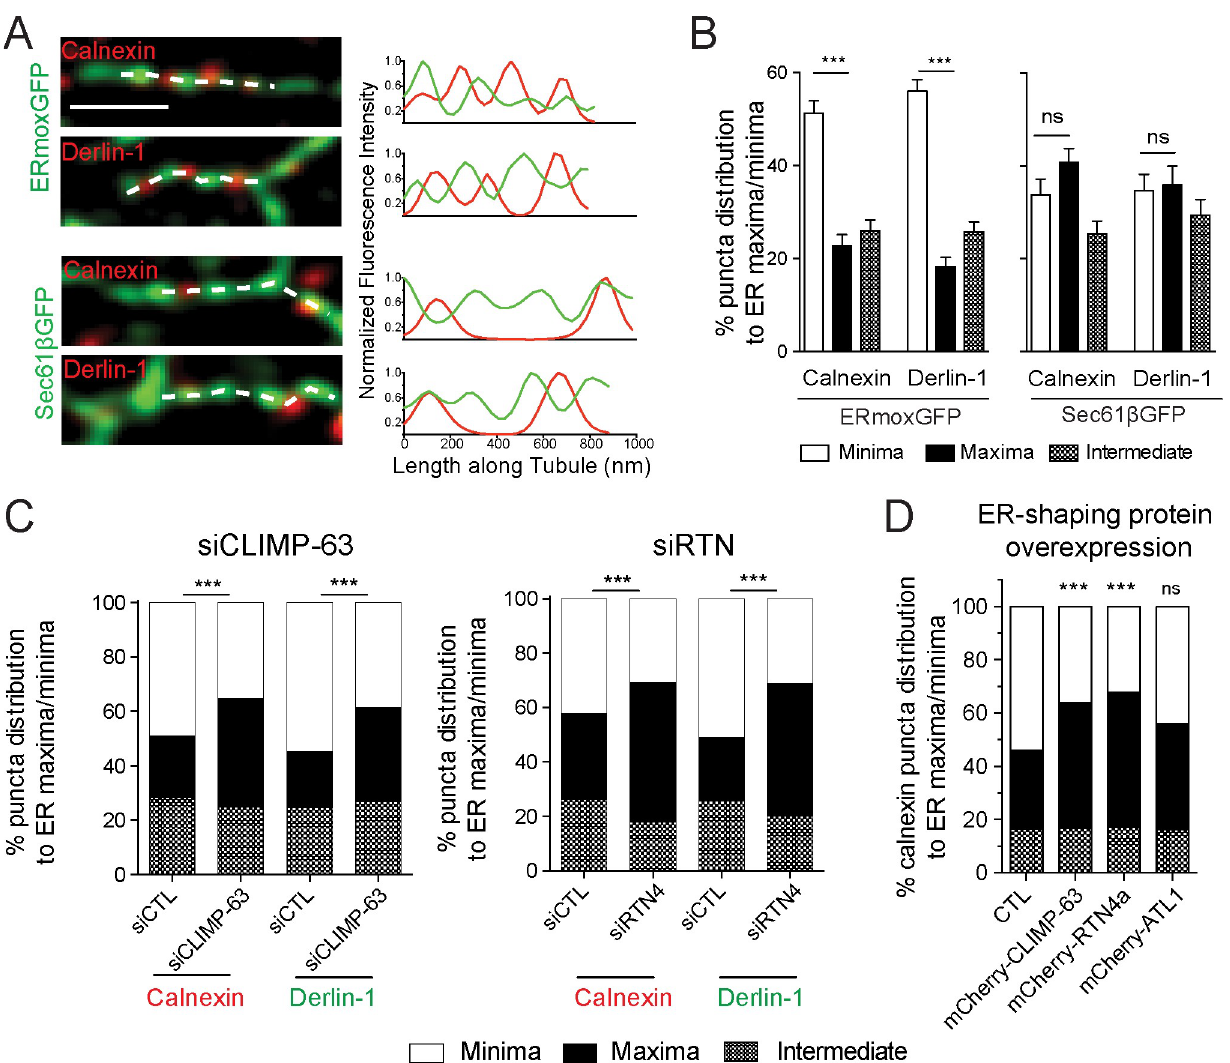
Fig 5. ER-resident proteins calnexin and derlin-1 are enriched in nanodomains depleted of lumenal ERmoxGFP. (A) Representative merged images of single peripheral ER tubules expressing ERmoxGFP or Sec61 β GFP labeled for calnexin or derlin-1. The dashed line indicates the site of line scan analysis along tubule. Fluorescence intensities of ER reporter (green) and protein (red) from line scans are presented as graphs. Scale bar, 0.5 μ m. (B) Based on line scan analysis of peripheral ER tubules, percent localization of calnexin and derlin-1 puncta to ERmoxGFP or Sec61 β GFP maxima and minima was quantified. Values plotted are mean ± SEM from three independent experiments (40 tubules per repeat) with one-way ANOVA for significance. ��� P < 0.001. Numerical values that underlie the graphs are shown in S1 Data. (C) Based on line scan analysis of peripheral ER tubules, percent localization of calnexin and derlin-1 puncta to ERmoxGFP maxima and minima was quantified in cells transfected with siCTL, siCLIMP-63, or siRTN4. Significance was assessed by χ 2 test from three independent experiments (20–40 tubules per repeat). ��� P < 0.001. Numerical values that underlie the graphs are shown in S1 Data. (D) Based on line scan analysis of peripheral ER tubules, percent localization of calnexin puncta to ERmoxGFP maxima and minima was quantified in HT-1080 cells cotransfected with mCherry-CLIMP-63, mCherry-RTN4a, or mCherry-ATL1 compared with CTL. Significance assessed by χ 2 test from three independent experiments (40 tubules per repeat). ��� P < 0.001. Numerical values that underlie the graphs are shown in S1 Data. ATL, atlastin; CLIMP-63, cytoskeleton-linking membrane protein 63; CTL, control; ER, endoplasmic reticulum; ERmoxGFP, ER monomeric oxidizing environment-optimized green fluorescent protein; ns, not significant; RTN4a, reticulon4a; siCLIMP-63, siRNA to CLIMP-63; siCTL, siControl; siRTN4, siRNA to